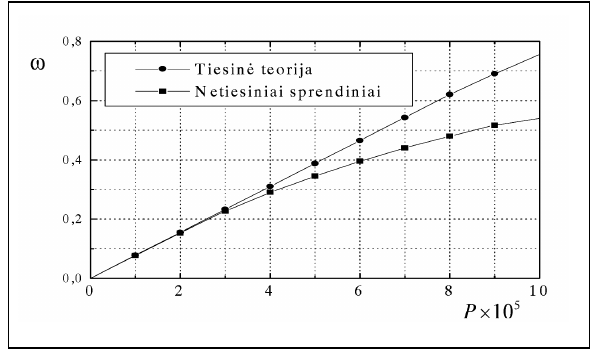
5 pav. Centrinio mazgo įlinkis Fig 5. Deflection of central